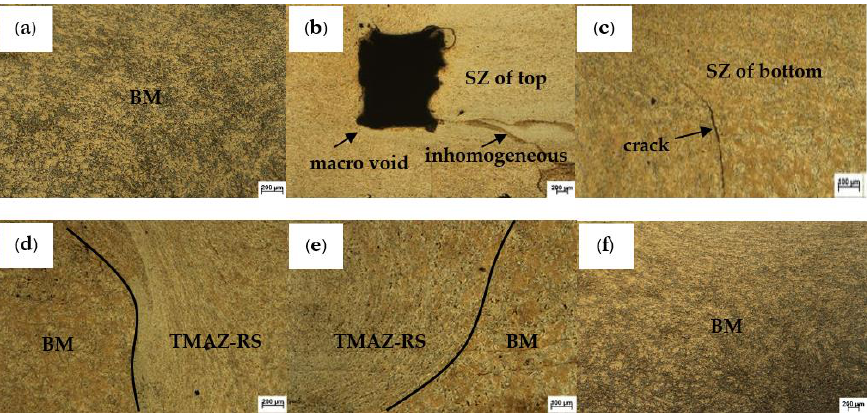
Figure 11. The microstructure photography evaluation by OM of optimal welding conditions of initial experiment: ( a , f ) BM, ( b , c ) SZ, ( e ) TMAZ-AS, and ( d ) TMAZ-RS.